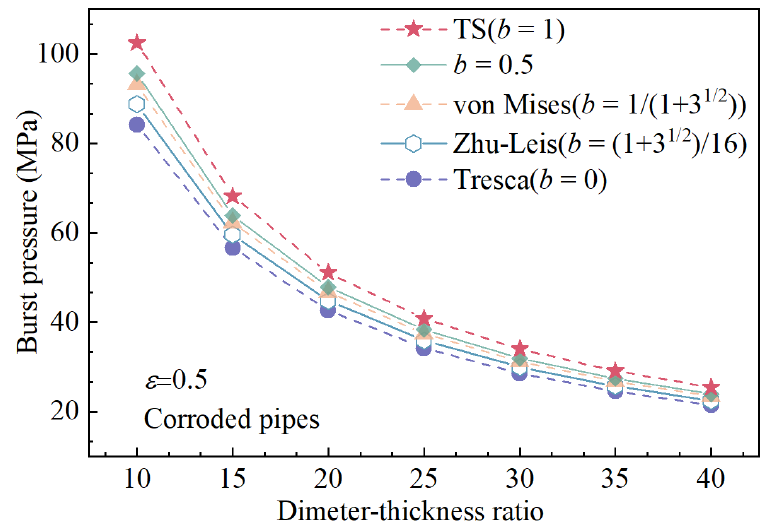
Figure 4. The influence of parameter b on burst pressure.